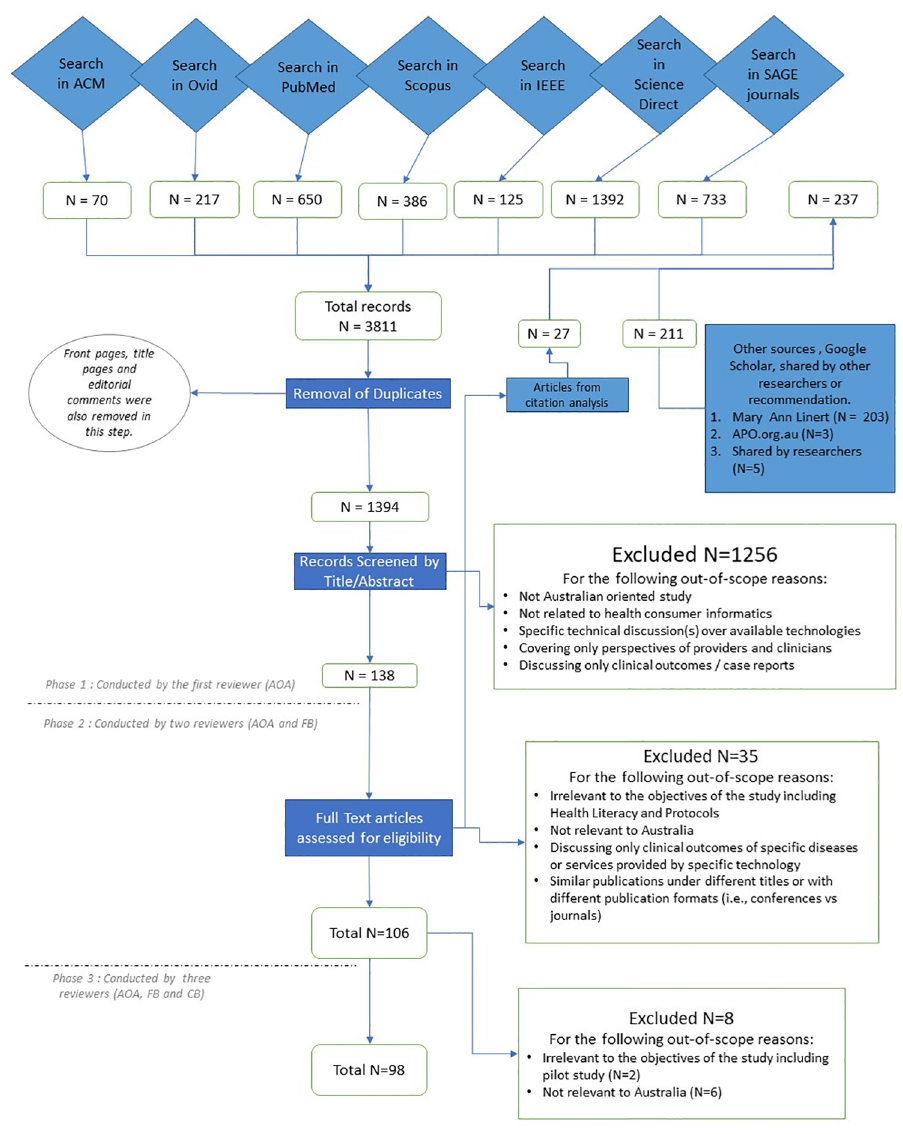
Fig 1. Flow chart of the study selection